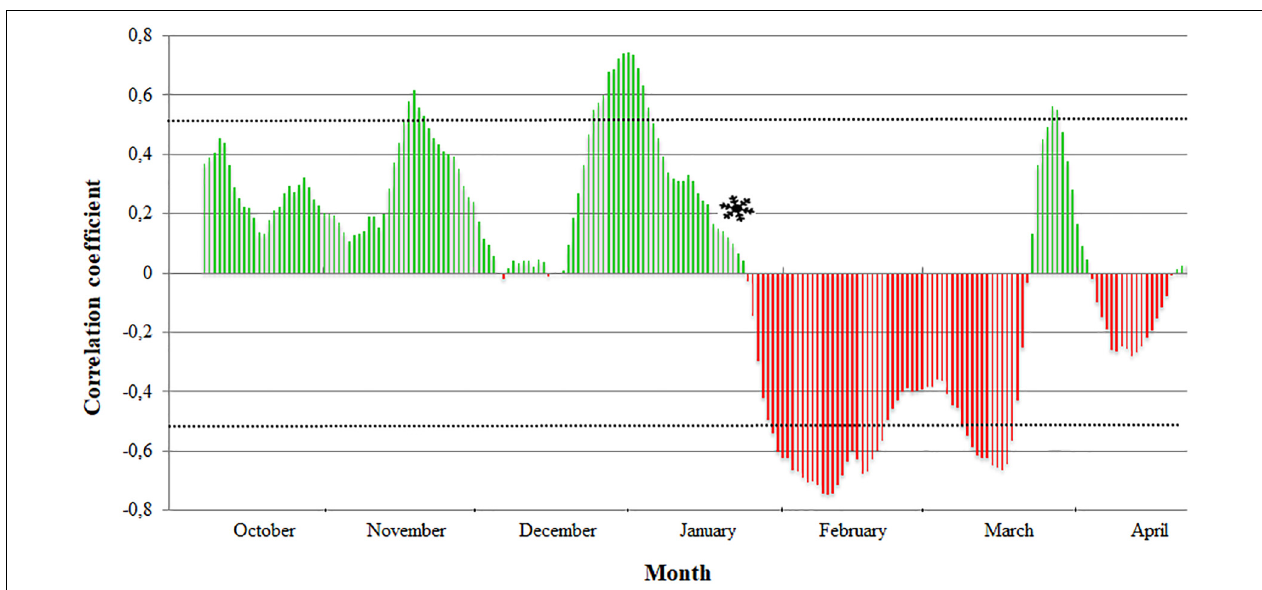
FIGURE 3 | Establishment of endodormancy breaking date ( (cid:2) ) in the apricot cultivar “Pandora” by analyzing the evolution of the Pearson correlation coefficients between the full flowering dates and the winter temperatures of periods of 15 days. Discontinuous lines delimit the significant values (0.553, –0.553). Green and red scales show positive and negative coefficients,